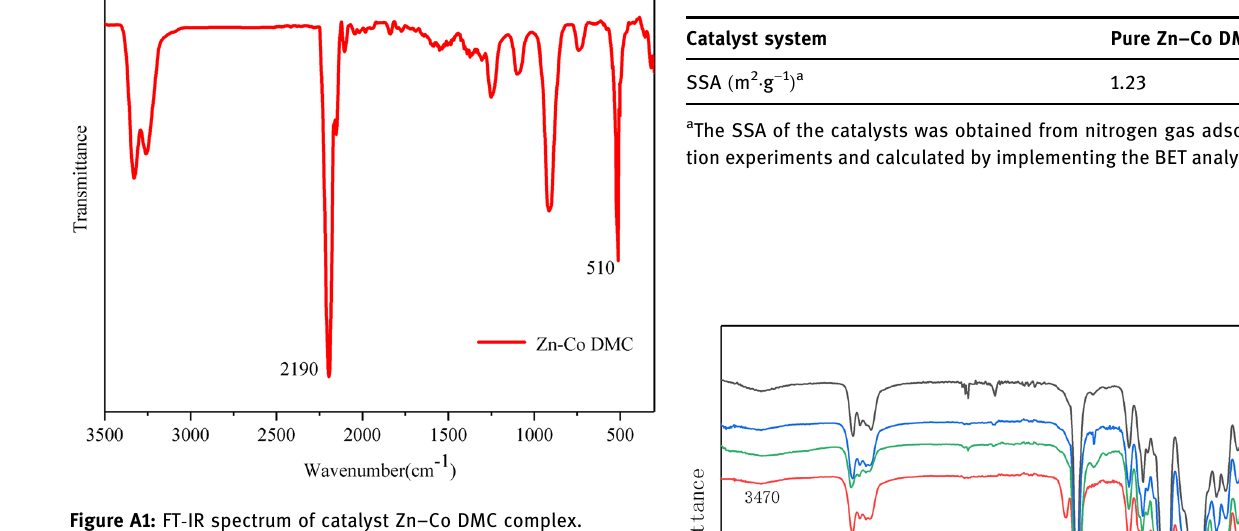
Table A1: Textural properties of the Zn – Co DMC complex